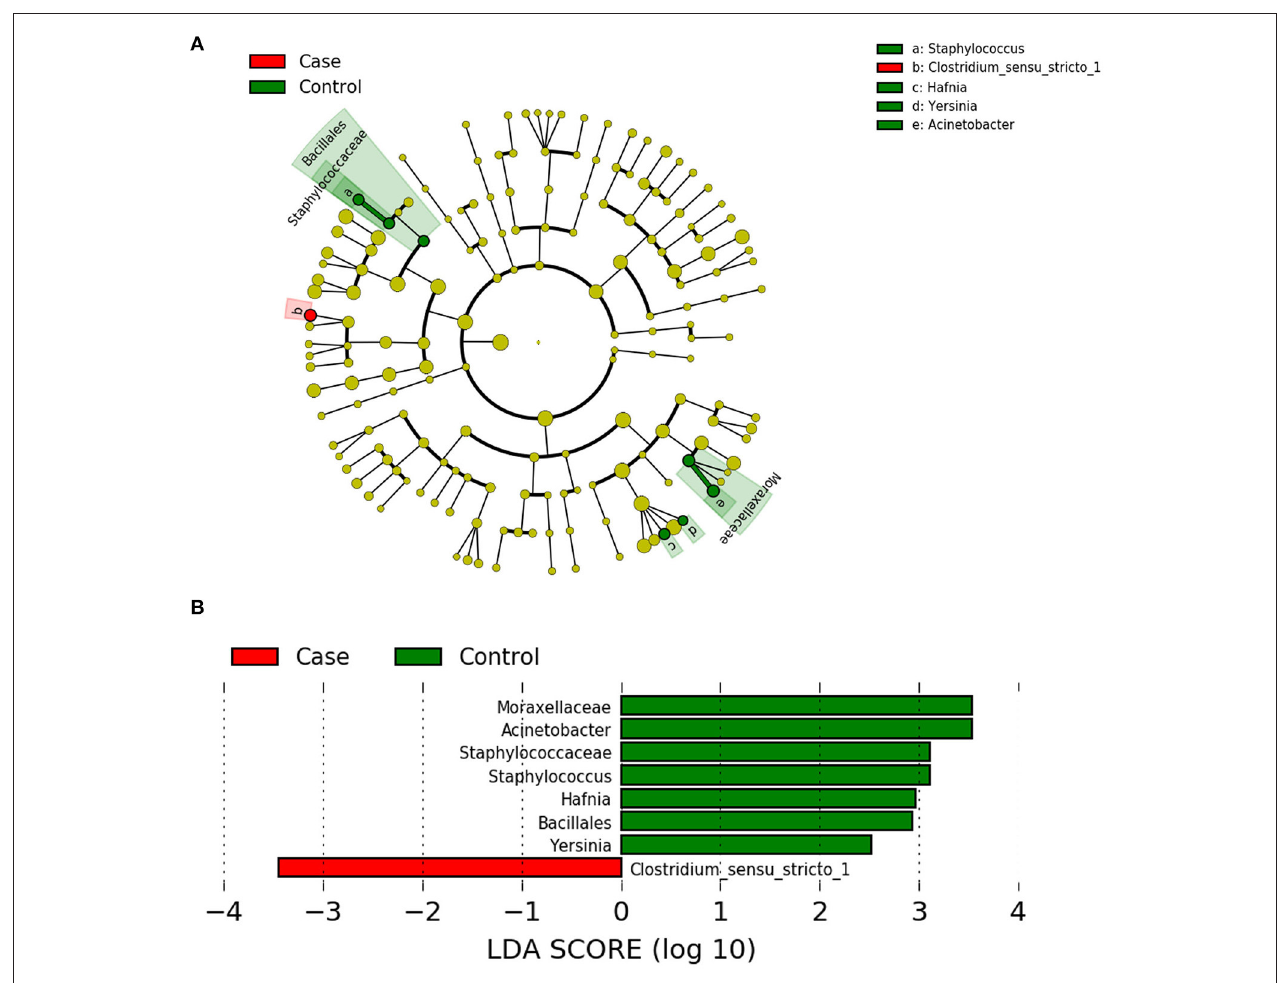
FIGURE 4 | (A) LEfSe cladogram, the diameter of each circle is proportional to the abundance. (B) Histogram of the LDA scores for diferentially abundant features among groups.